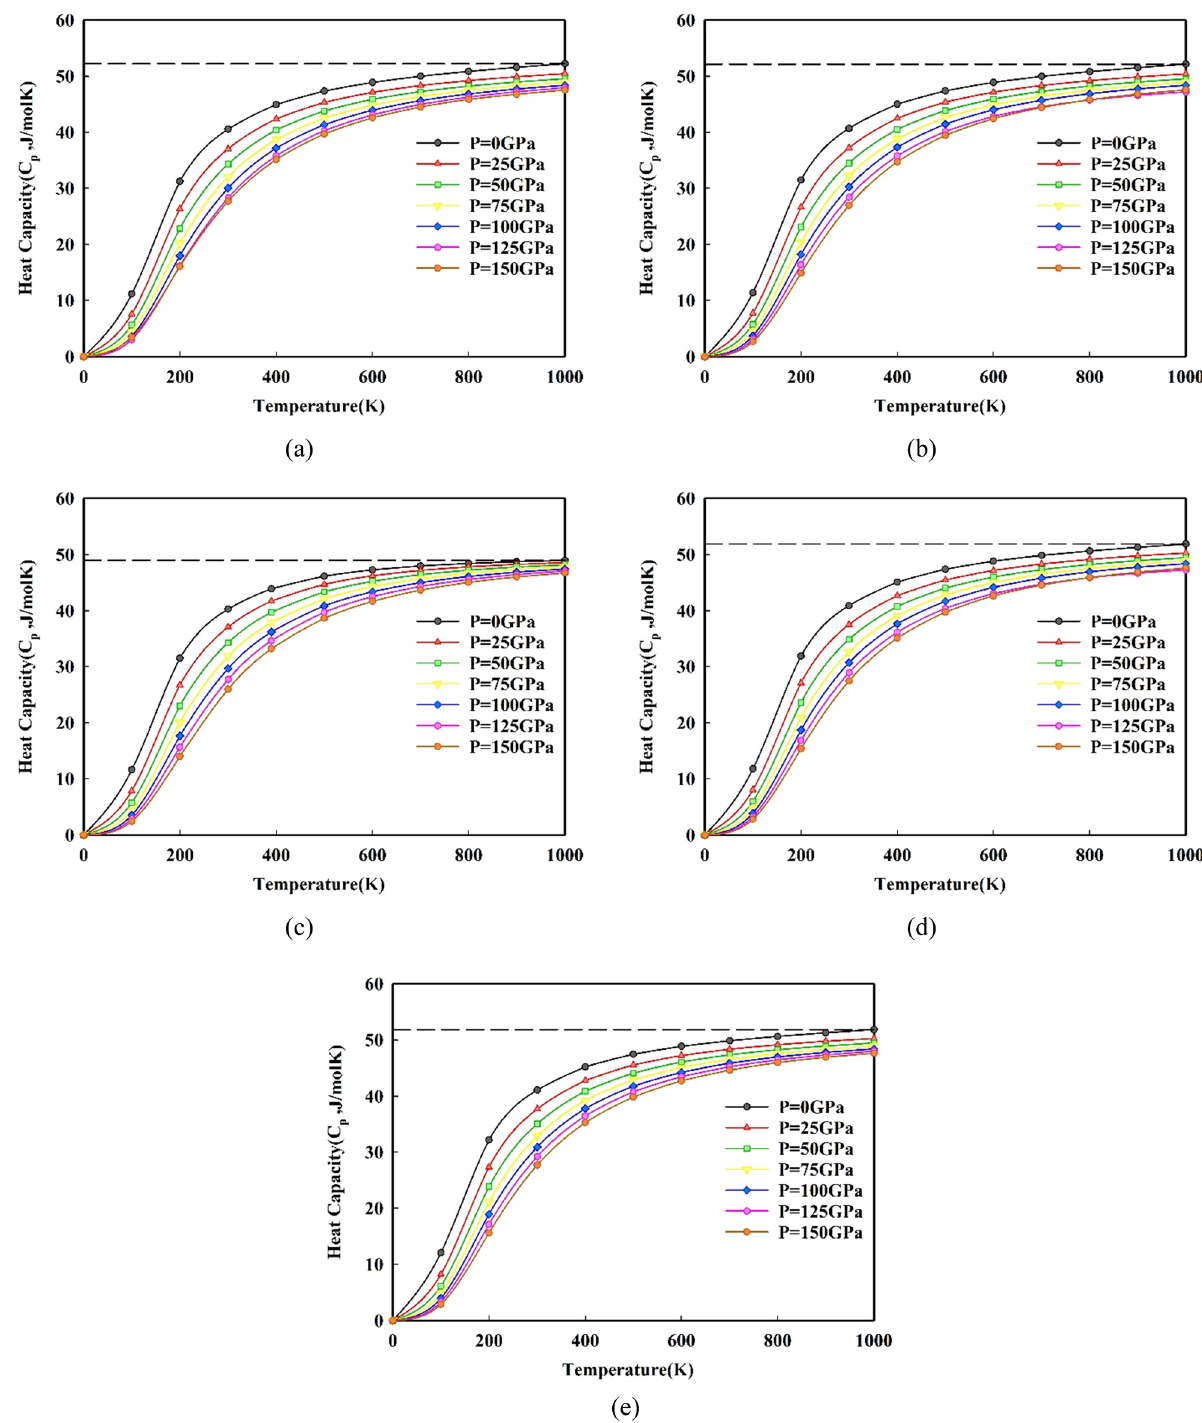
Figure 8: Constant pressure heat capacity as a function of temperature and for di ff erent pressures for ( a ) ZrC, ( b ) ZrC 0.75 N 0.25 , ( c ) ZrC ( d ) ZrC ( e ) 0.50 N 0.50 , 0.25 N 0.75 , and